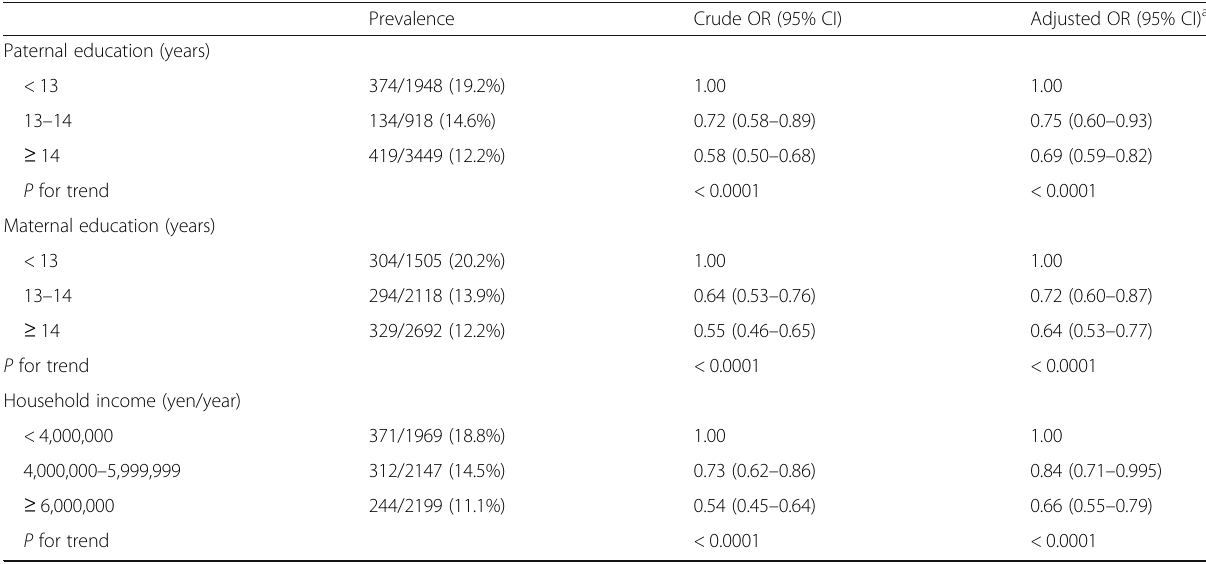
Table 3 ORs and 95% CIs for dental caries in relation to parental educational levels and household income in 6315 Japanese children aged 3